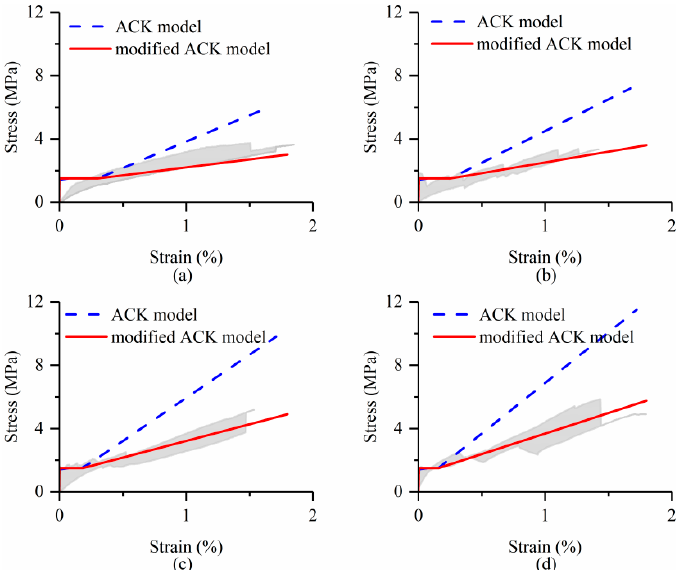
Figure 11. Tensile stress-strain curves of BTRC composites (experimental results VS predictions of ACK model): ( a ) I-L1; ( b ) I-L2; ( c ) I-L3; ( d ) I-L4.